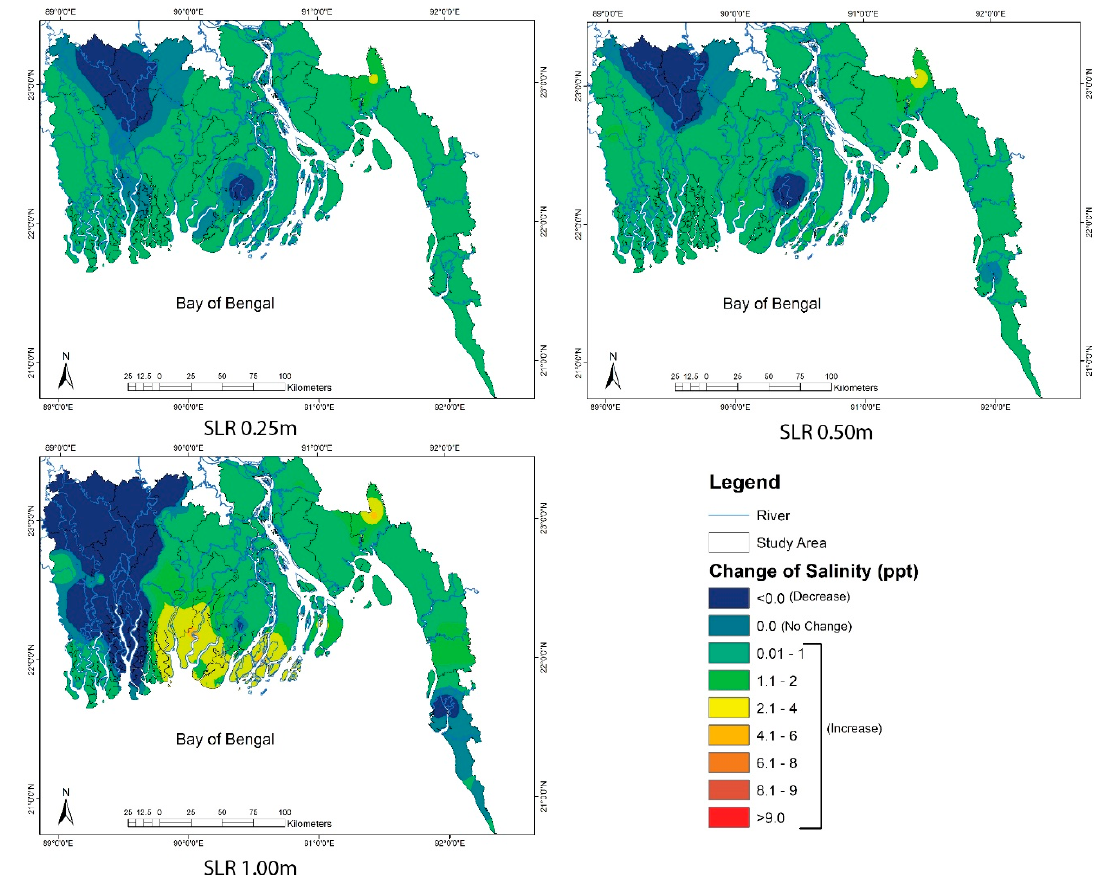
Figure 10. Change of salinity magnitude for SLR (0.25, 0.50, 1.00 m)